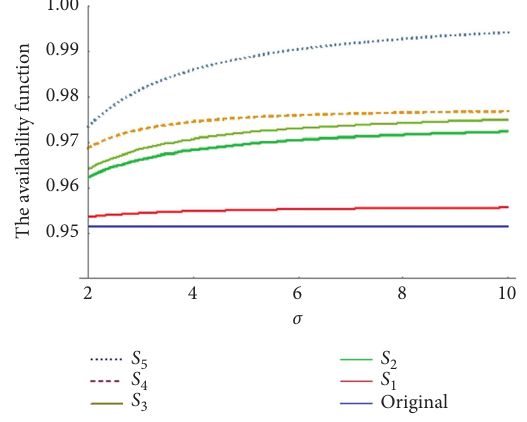
Figure 4: The A Table 1: The A D B ∈ S i